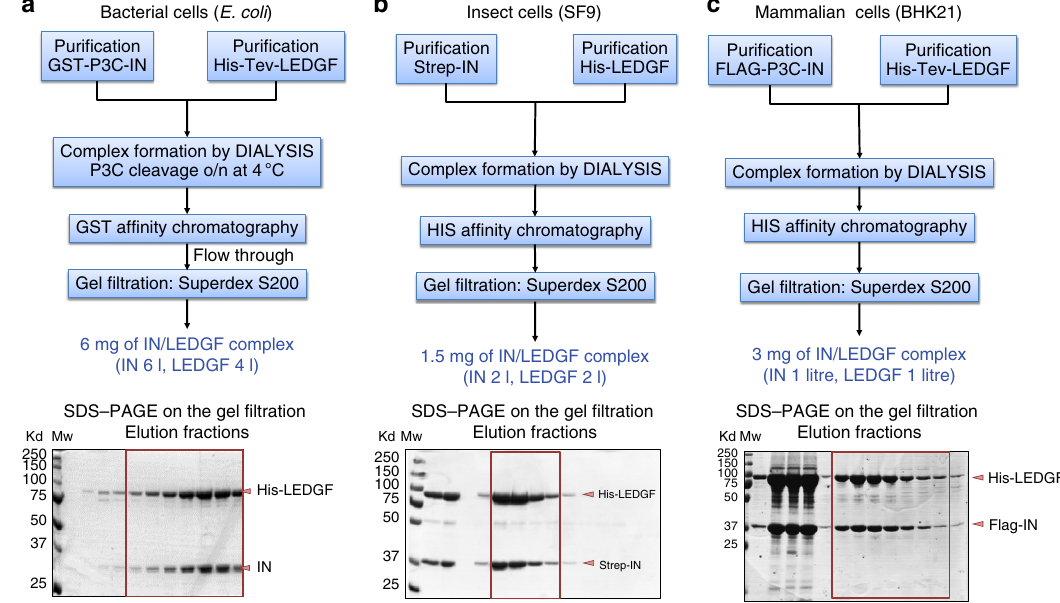
Figure 5 | Production and purification of the HIV-1 IN and human LEDGF complex. The complex was produced in ( a ) E. coli , ( b ) insect and ( c ) mammalian cells. Proteins were produced and purified separately. The complex was formed by mixing the two proteins and by the removal of the solubilizing agents followed by a gel filtration chromatography. The elute fractions were analysed by